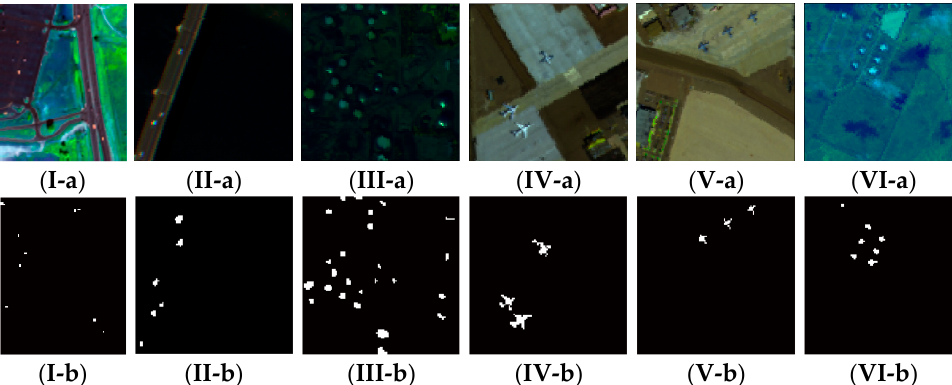
Figure 6. Visualization of the experimental datasets: ( a ) color composites and ( b ) reference map; ( I ) HYDICE, ( II ) Pavia, ( III ) Los Angeles, ( IV ) San Diego-I, ( V ) San Diego-II and ( VI) Texas